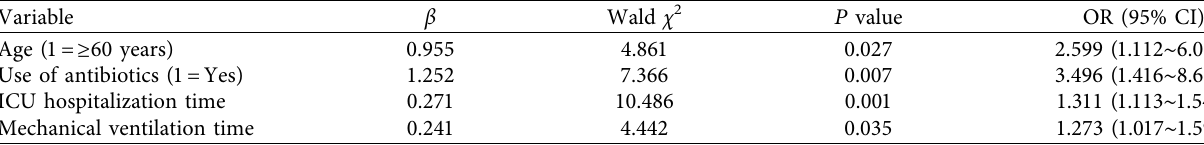
Table 4: Multivariate logistic regression analysis results.